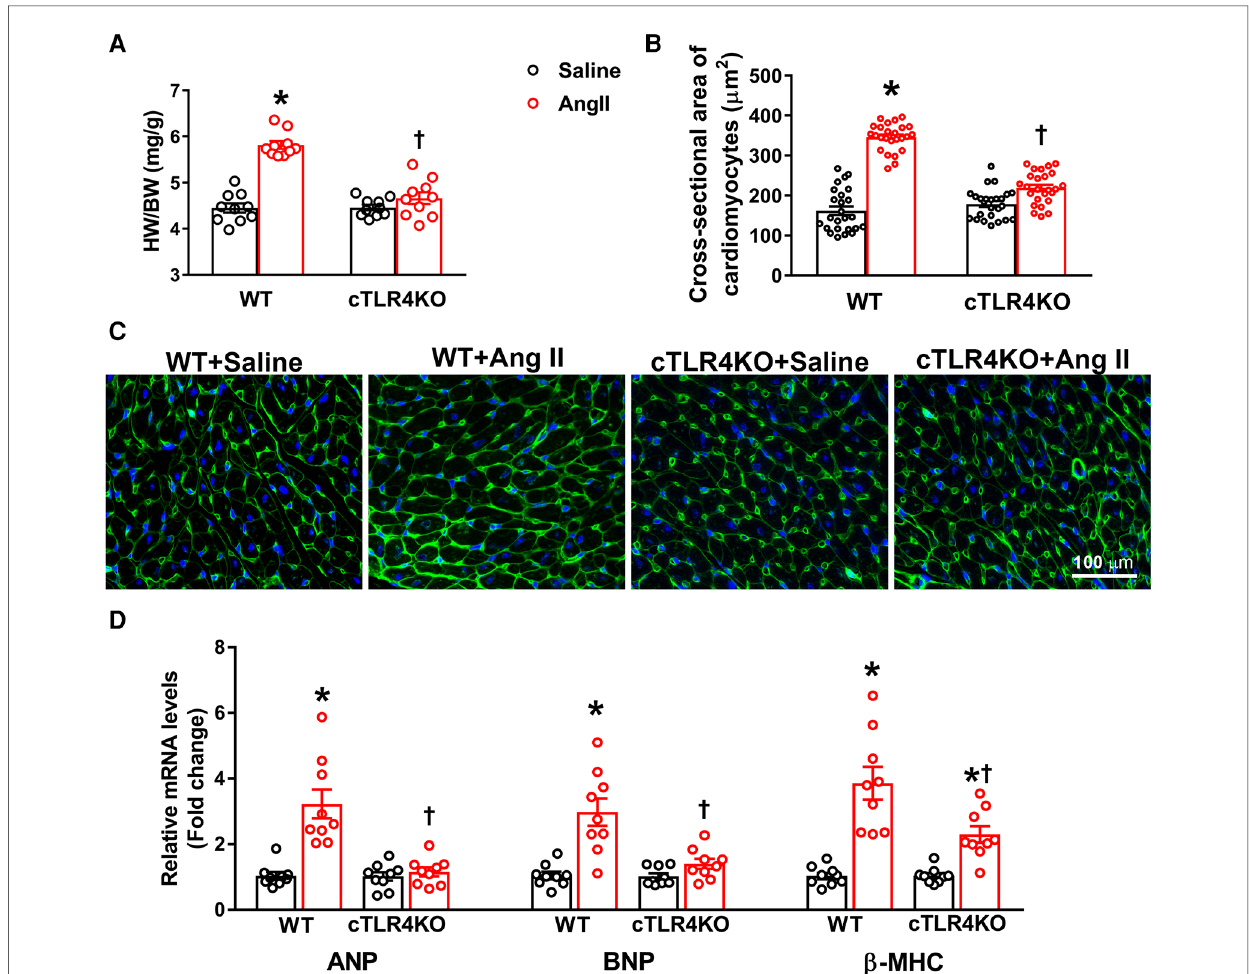
FIGURE 3 Cardiomyocyte-speci fi c TLR4 deletion abrogates angiotensin II-induced cardiac hypertrophy. ( A ) Cardiac hypertrophy was measured by calculating heart weight/body weight (HW/BW) ratio. Ang II increased heart weight to body weight in WT mice, but this effect was blunted in cTLR4KO mice ( n =10, two- way ANOVA, * p <0.05 vs. WT+Saline, † p <0.05 vs. WT+Ang II). ( B ) To visualize cardiomyocyte hypertrophy, we used wheat germ agglutinin immuno fl uorescence staining to measure cardiomyocyte cross-sectional area (µM 2 ). Quanti fi cation data showing a signi fi cant increase in cardiomyocyte cross-sectional area in WT mice treated with Ang II, which was attenuated in cTLR4KO mice ( n =4 mice/group, two-way ANOVA, * p <0.05 vs. WT+Saline, † p <0.05 vs. WT+Ang II). ( C ) Representative heart images showing immuno fl uorescence staining with wheat germ agglutinin. ( D ) Real time RT-PCR was used to measure gene expression of natriuretic peptides ANP, BNP and β -MHC. In hypertensive WT mice there is a signi fi cant elevation in these natriuretic peptides, which is attenuated in cTLR4KO mice ( n =9, two-way ANOVA, * p <0.05 vs. WT+Saline, † p <0.05 vs. WT+Ang